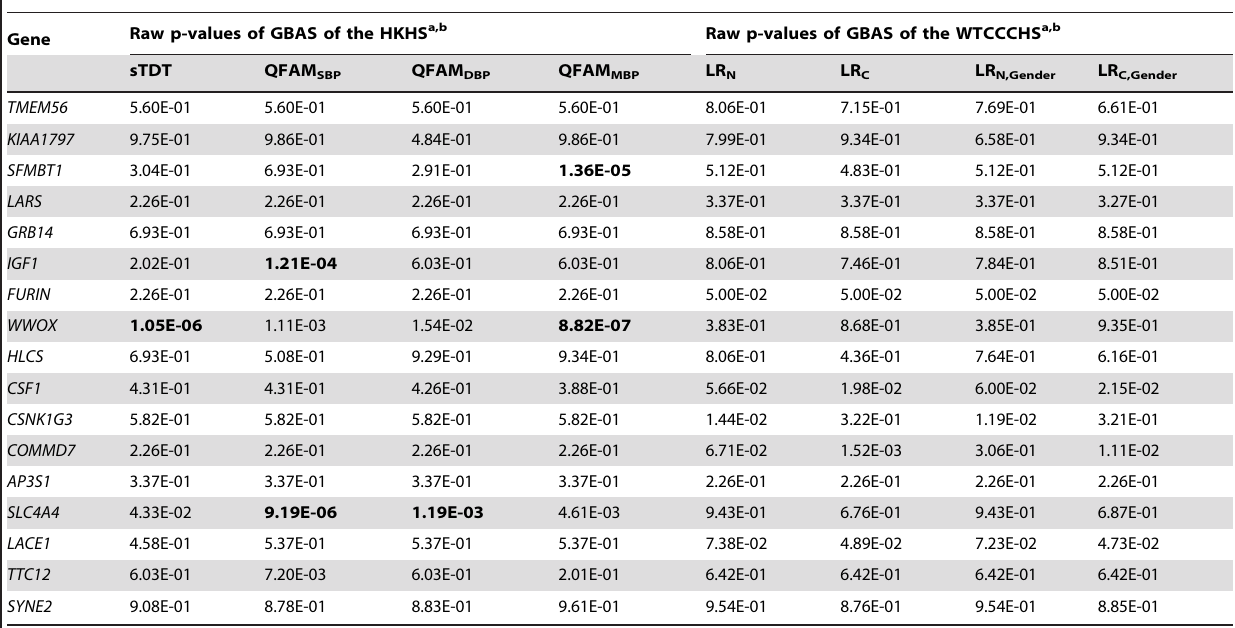
Table 3. Replication analysis of the seventeen genes with differential allelic and transcriptional distributions in cases and controls.